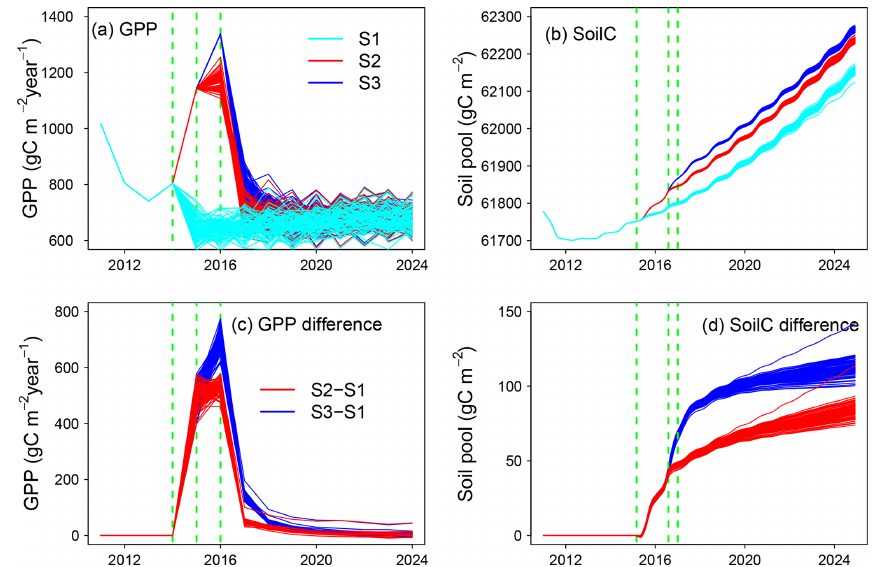
Figure 6. Updated vs. un-updated forecasting of gross primary production (GPP; panels a , c ) and soil organic C content (SoilC; panels b , d ). The upper panels show three series of forecasting with updated vs. stochastically generated weather forcing. “Updated” means the real meteorology forcing monitored from field weather stations. Cyan indicates forecasting with 100 stochastically generated weather forcings from January 2015 to December 2024 (S1); red corresponds to updated forecasting with two stages, which is updating with measured weather forcing from January 2015 to July 2016, followed by forecasting with 100 stochastically generated weather forcings from August 2016 to December 2024 (S2); and blue shows updated forecasting with measured weather forcing from January 2015 to December 2016, followed by forecasting with 100 stochastically generated weather forcings from January 2017 to December 2024 (S3). Panels (c) and (d) display mismatches between updated forecasting (S2, 3) and the original un-updated forecasting (S1). Red displays the difference between S2 and S1 (S2–S1), and blue shows the discrepancy between S3 and S1 (S3–S1). Dashed green lines indicate the start of forecasting with stochastically generated weather forcing. Note that panels (a) and (c) are plotted on a yearly timescale and panels (b) and (d) show results on a monthly